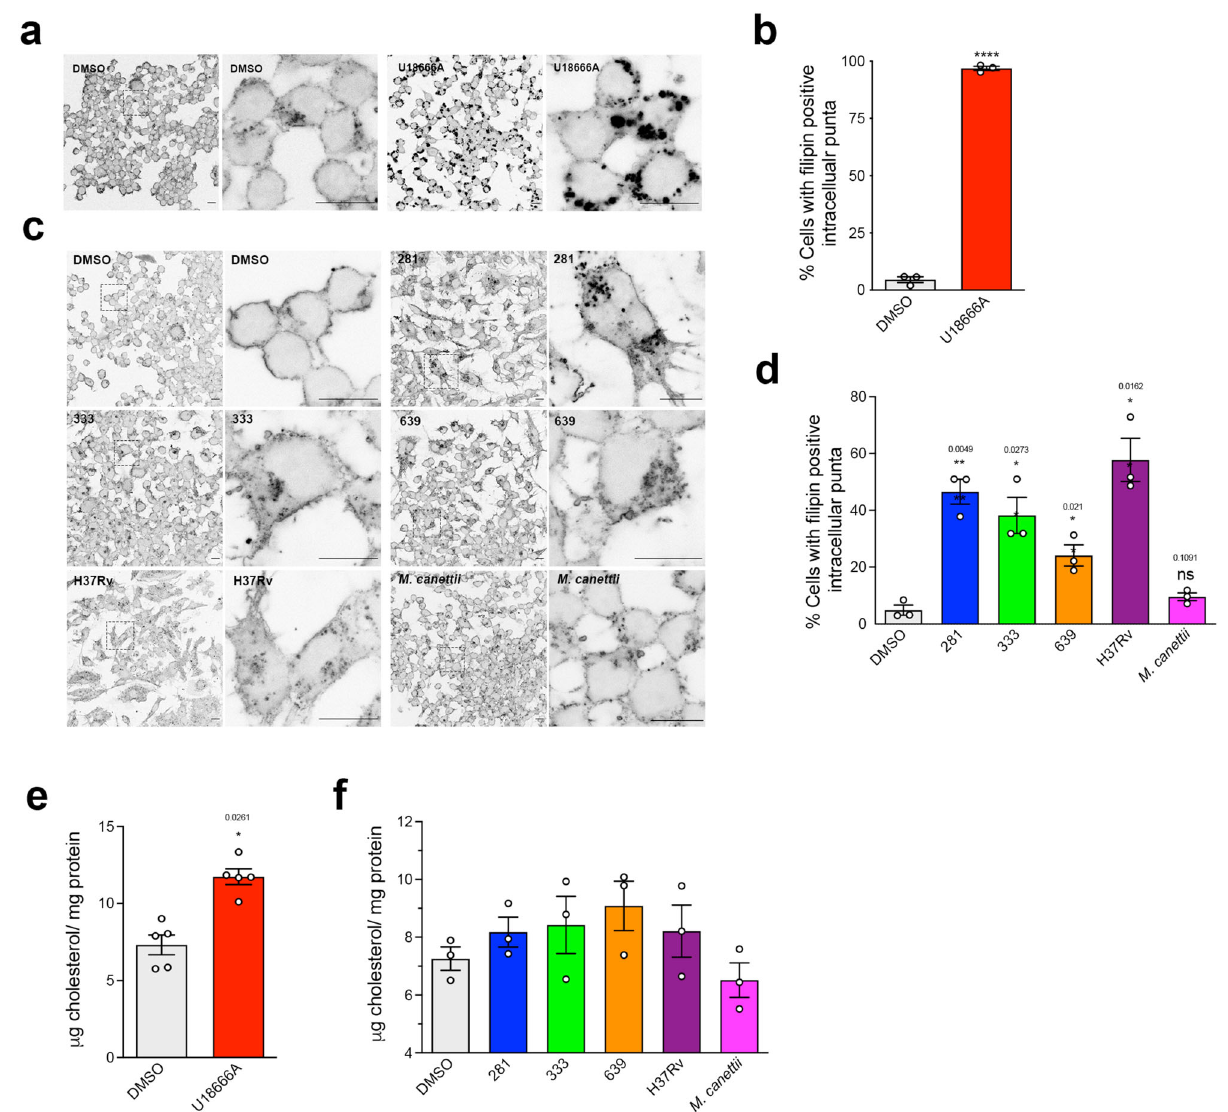
Fig. 5| Mtblipidsinduceapartialredistributionofcholesteroltointracellular puncta in RAW 264.7M Φ . a Confocal microscopy images of vehicle (DMSO) or U18666AtreatedRAW264.7M Φ stainedwith fi lipin.Foreachpair,therightimage is a higher magni fi cation of the region outlined in the left image. Scale bar repre- sents 5 μ m. b Quantitation of the frequency of vehicle or U18666A treated cells with fi lipin positive intracellular puncta. Data are mean±SEM, N =3, each repre- senting a minimum of 100 cells in randomly selected fi elds. Statistical analysis, unpaired t test with Welch ’ s correction, two-tailed. **** p <0.0001. c Confocal microscopy images ofRAW264.7M Φ treated with vehicle(DMSO),Mtb strains or M. canettii lipids stained with fi lipin. For each pair, the right image is a higher magni fi cation of the region outlined in the left image. Scale bar represents 5 μ m. d Quantitation of the frequency of DMSO, Mtb lipids, or M. canettii lipid treated